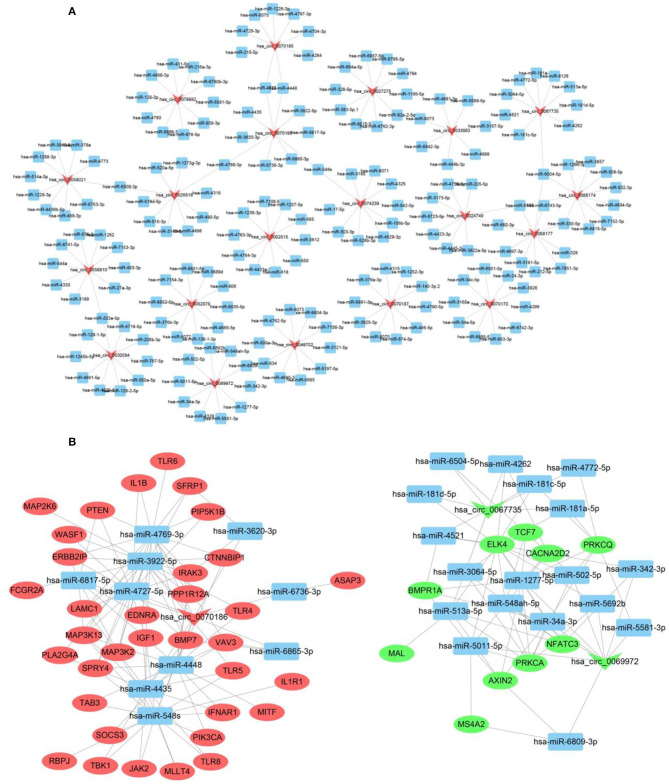
CircRNA–miRNA–mRNA interaction network. (A) CircRNA–miRNA interaction network of the top 10 up-regulated and down-regulated circRNAs. (B) CircRNA–miRNA–mRNA interaction network of three selected circRNAs. Inverted triangles represent circRNAs; rectangles represent the predicted miRNAs; ellipse nodes represent mRNAs (red, up-regulated; green, down-regulated).